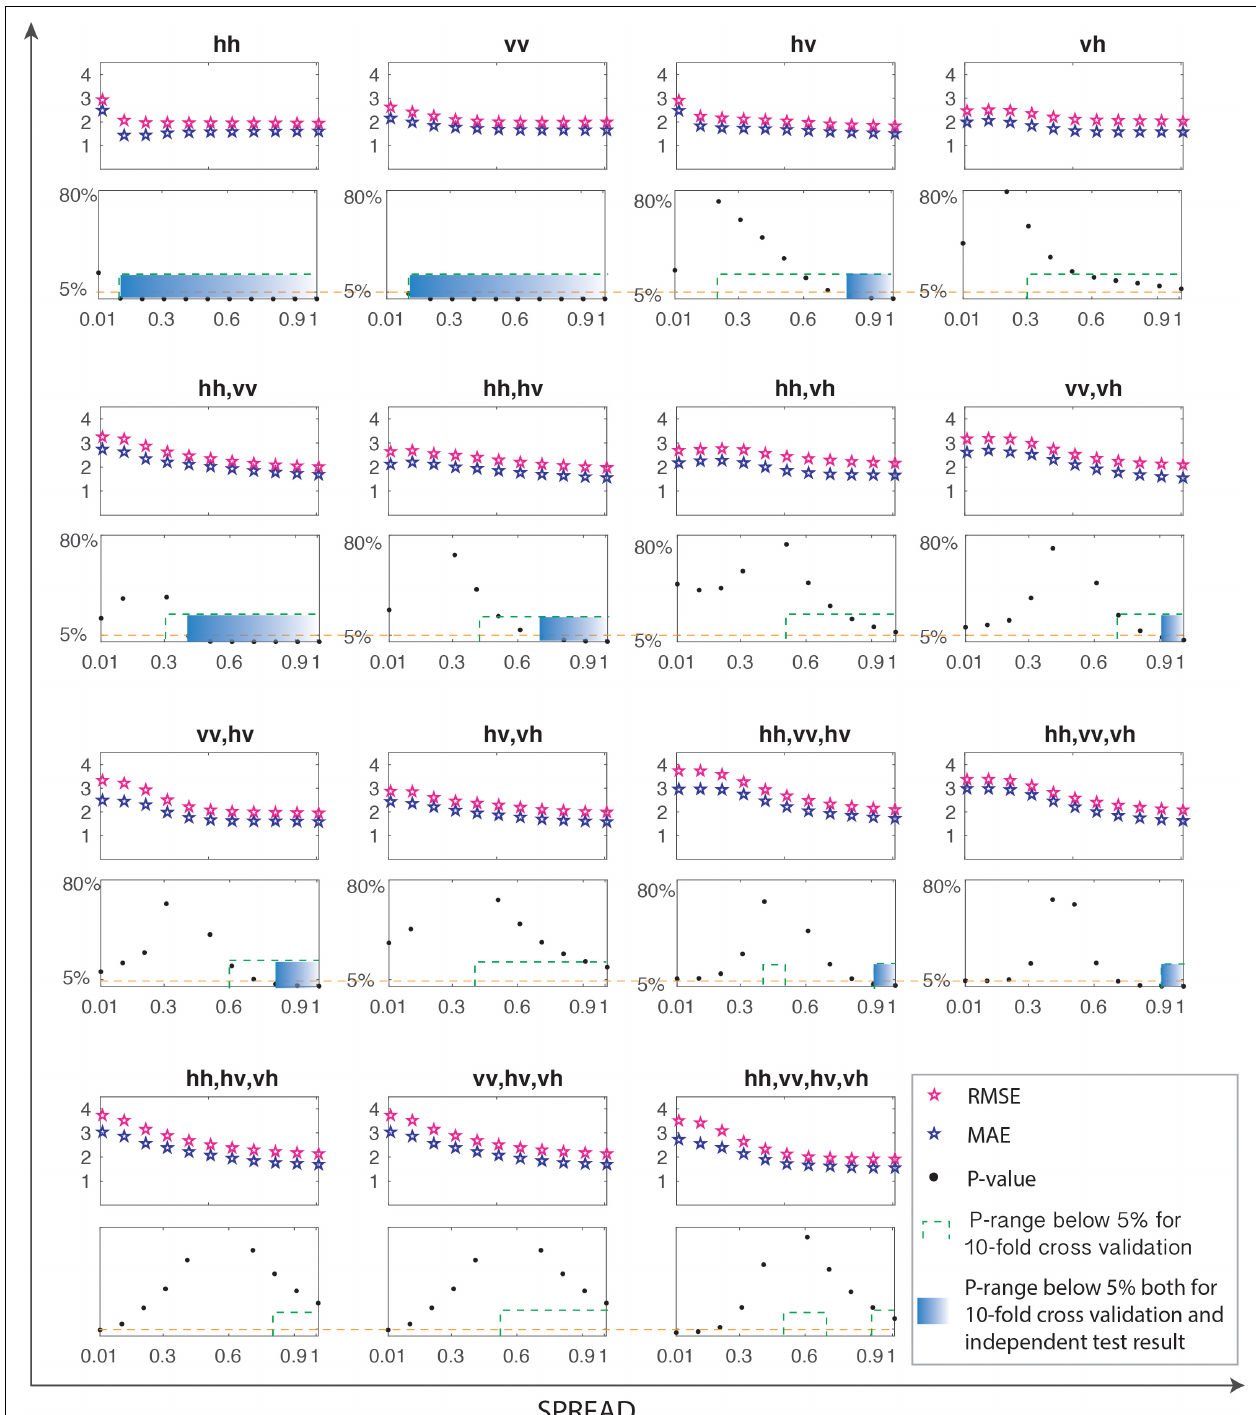
FIGURE 4 | The performance metrics of 15 backscatter-BSSM models by independent test under the spread of 0.01 to 1.